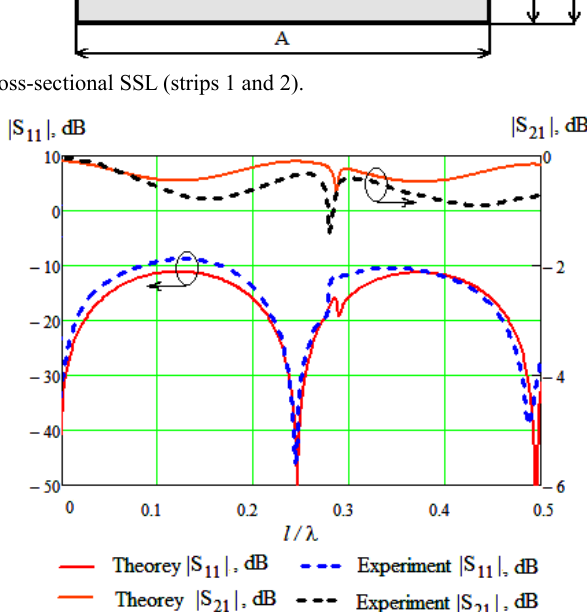
Fig. 8. Theoretical and experimental dependences of insertion and return loss of the SSL segment of the scheme (Fig. 1) at the ratio of the length to the wavelength of affecting signal in free space.